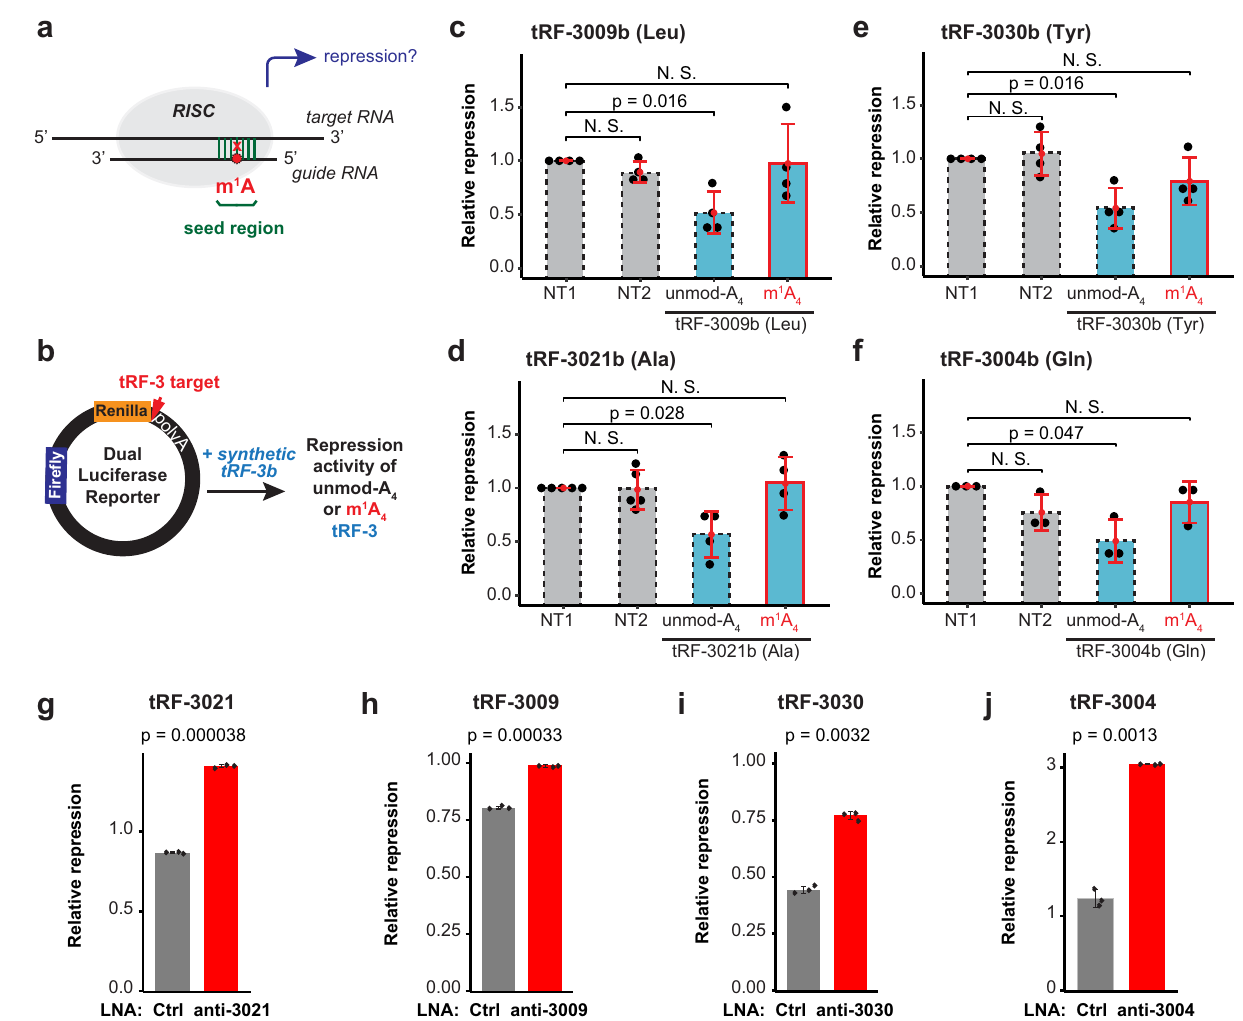
Fig. 4 m 1 A attenuates gene silencing by tRF-3s. a m 1 A is located within the seed region of tRF-3b, which represents the guide RNA in RISC (RNA-induced silencing complex). m 1 A may interfere with base pairing between tRF-3b and the target RNA, thus alleviate target repression. b Scheme of the dual luciferase reporter assay to measure tRF-3 gene-silencing activity. tRF-3b complementary target sequence is inserted in the 3 ′ UTR of Renilla luciferase (Rluc) gene. Fire fl y luciferase (Fluc) signal is used for normalization. Synthetic tRF-3b with unmodi fi ed A 4 or m 1 A-modi fi ed A 4 is co-transfected with the reporter plasmid to measure relative effect of tRF-3b on the reporter activity. c – f Relative tRF-3 gene-silencing activity is measured by the dual luciferase reporter assay in HEK293T. Relative activity is calculated from Rluc signal divided by Fluc signal, and normalized to the empty site reporter; NT1 (non- targeting control1) is set as 1 in each replicate. g – j Relative tRF-3 gene-silencing activity is de-repressed after tRF-3 knock-down by LNAs (lock nucleic acids). Relative activity is calculated from Rluc signal divided by Fluc signal and normalized to the empty site reporter. Non-targeting LNA was used as control (Ctrl). All data are represented as mean ± SD; p value based on two-tailed paired student ’ s t test from three (four for d , e ) independent experiments. Source data are provided as a Source Data fi